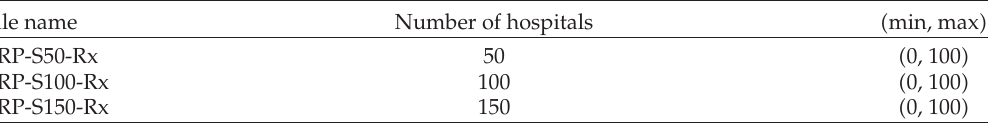
Table 5: The general details of the generated instances.